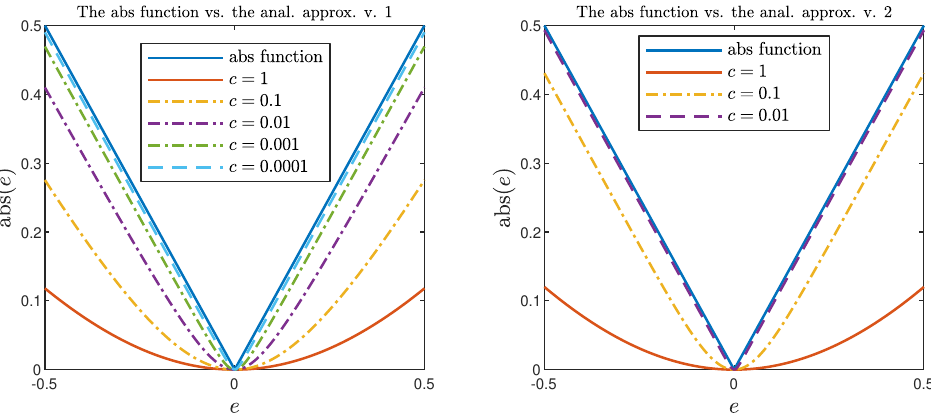
Figure 2. Comparison between the absolute value function and its analytical approximations for different values of parameter c